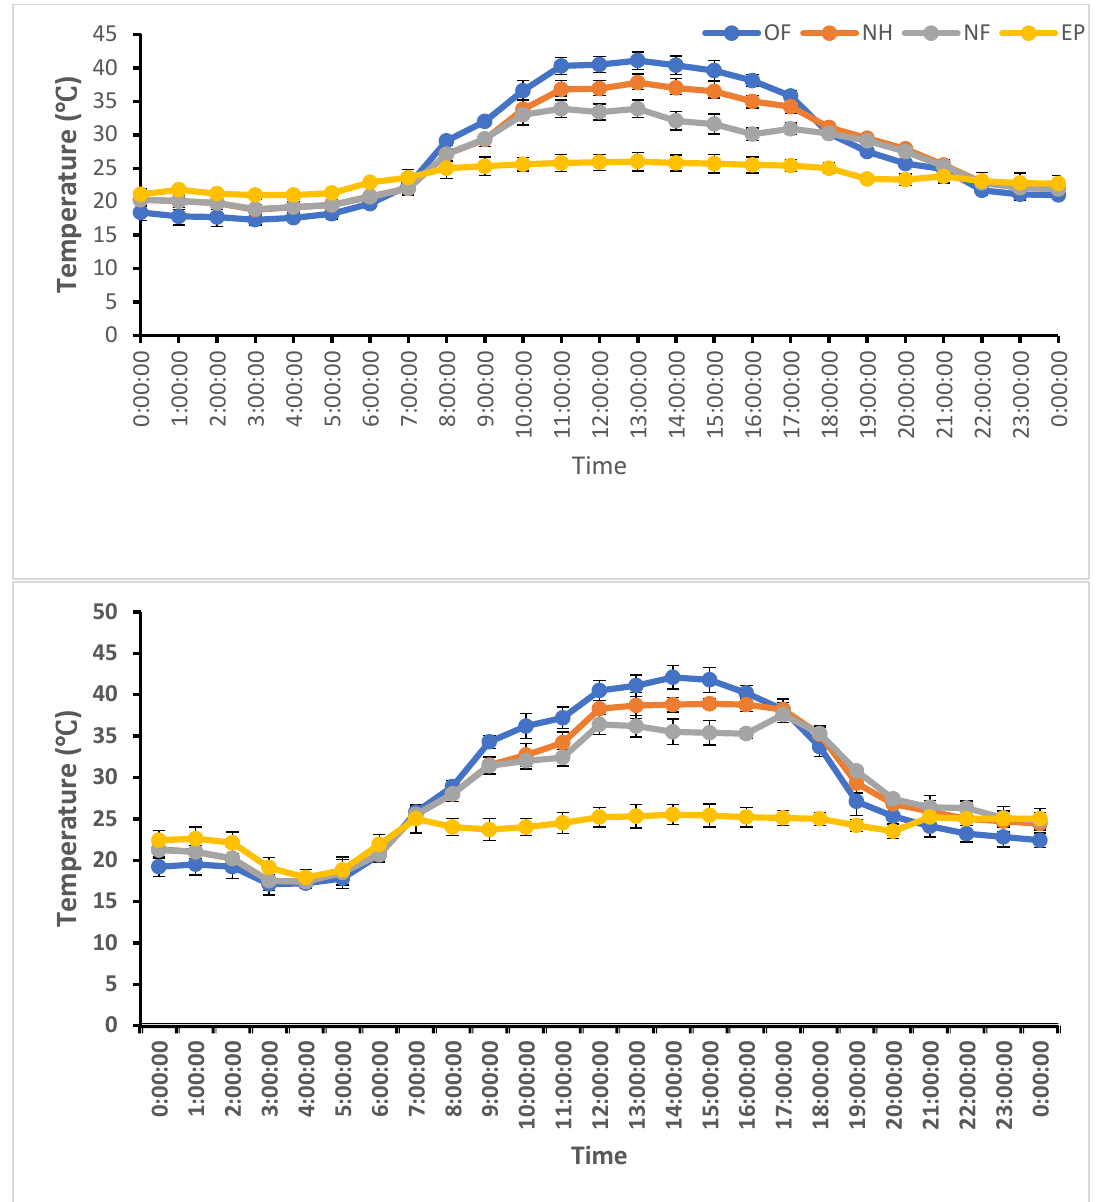
Figure 2. Hourly temperature changes during the peak of flowering and fruit set on 3 August 2020 ( upper figure ) and 5 August 2021 ( lower figure ) registered in the open field (OF), net house (NH), net house with fogging (NF, operating 6 S/36 S from 10 a.m. to 4 p.m.) and evaporative cooling under plastic house (EP). Standard error of the means was derived from three biological